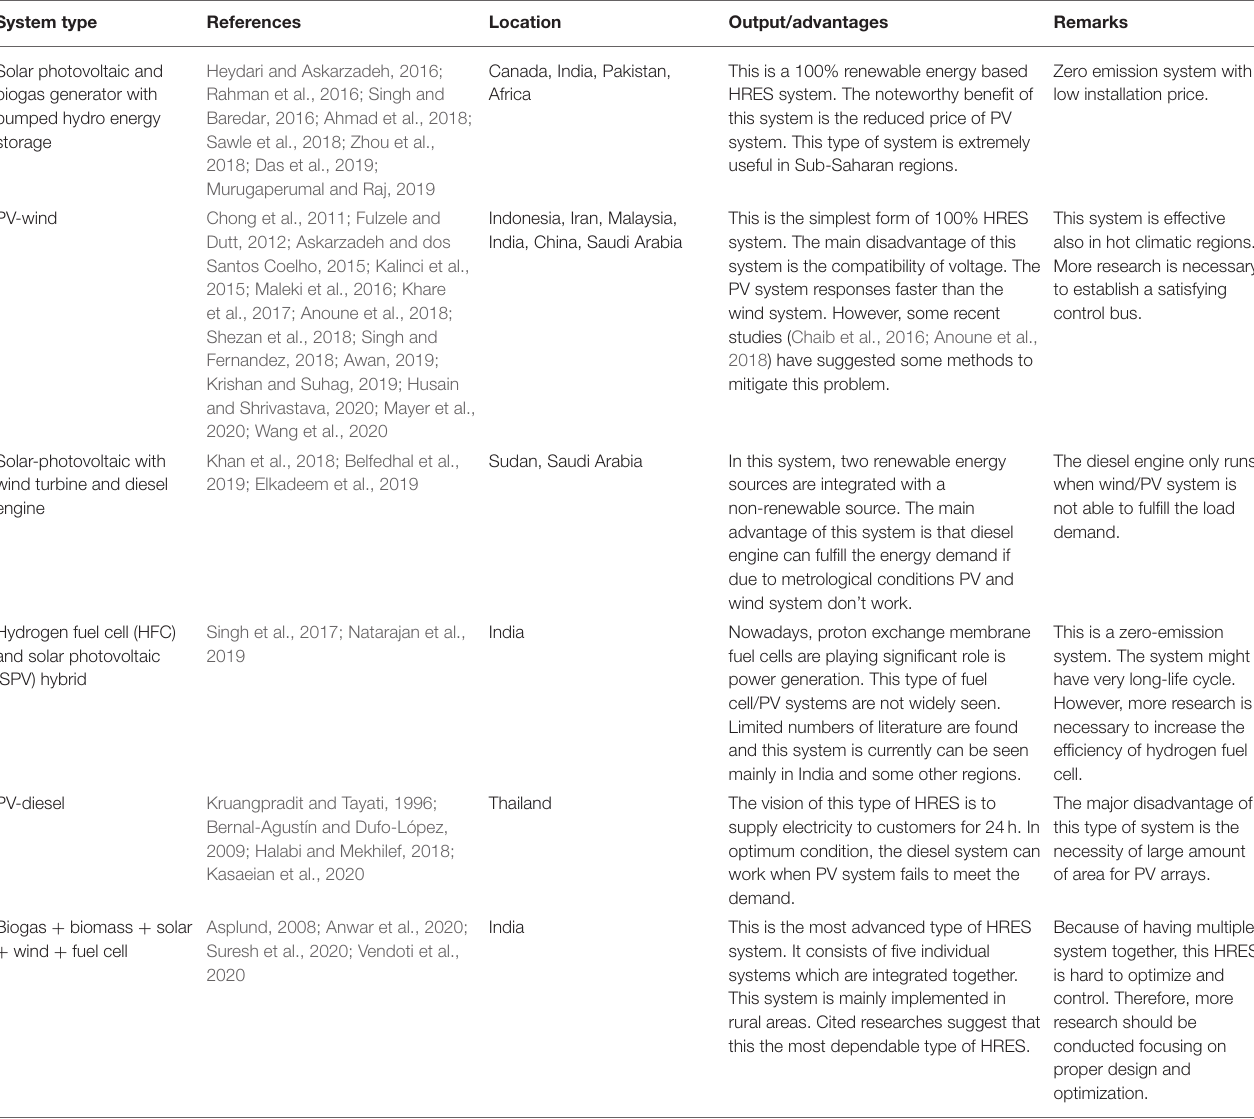
TABLE 1 | HRES technologies implemented around the